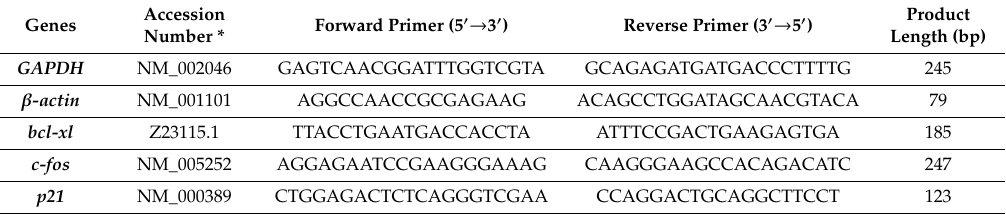
Table 1. Primer sequences, accession numbers, and product lengths for quantitative real-time PCR (qRT-PCR)